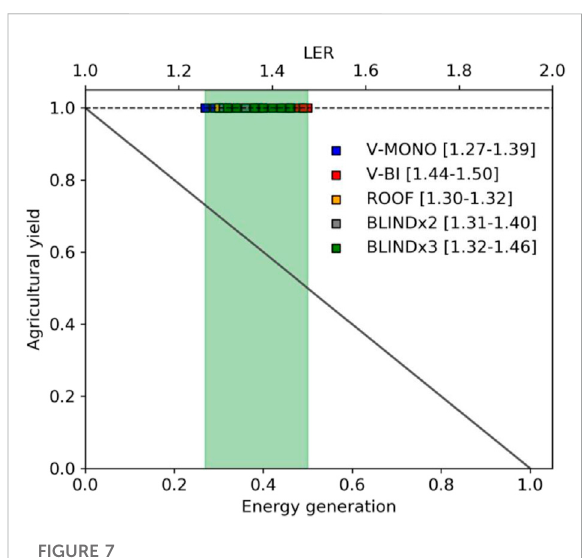
FIGURE 7 Land Equivalent Ratio (LER) for each PV con fi